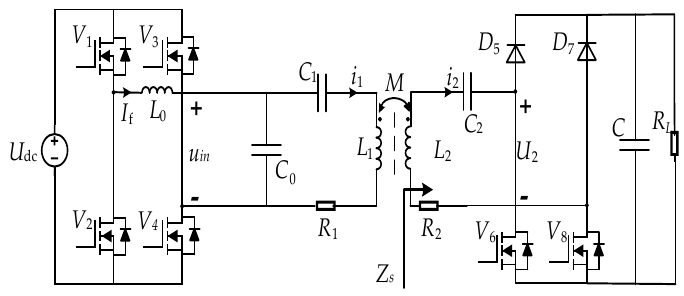
Figure 1. LCC-S type resonant equivalent circuit.